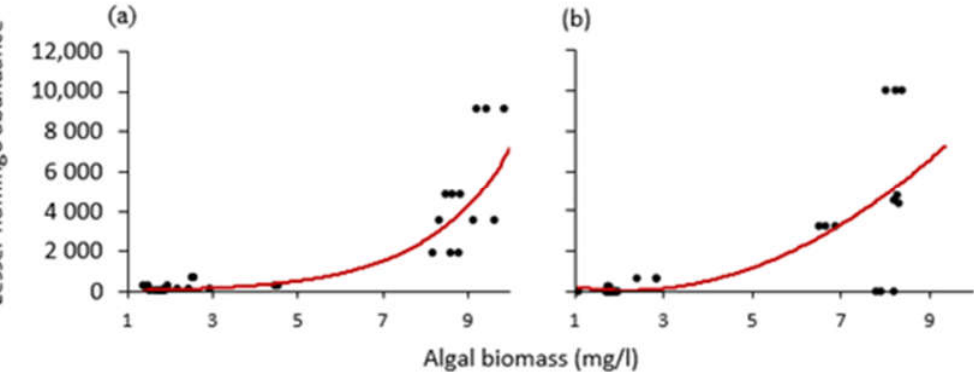
Figure 9. Scatter diagrams with curved lines showing how the relationship changed between lesser flamingo abundance and algal biomass at lakes; ( a ) Big Momella and ( b ) Rishateni, during the study period from May 2020 to April 2021 at lakes Big Momella, northern Tanzania.